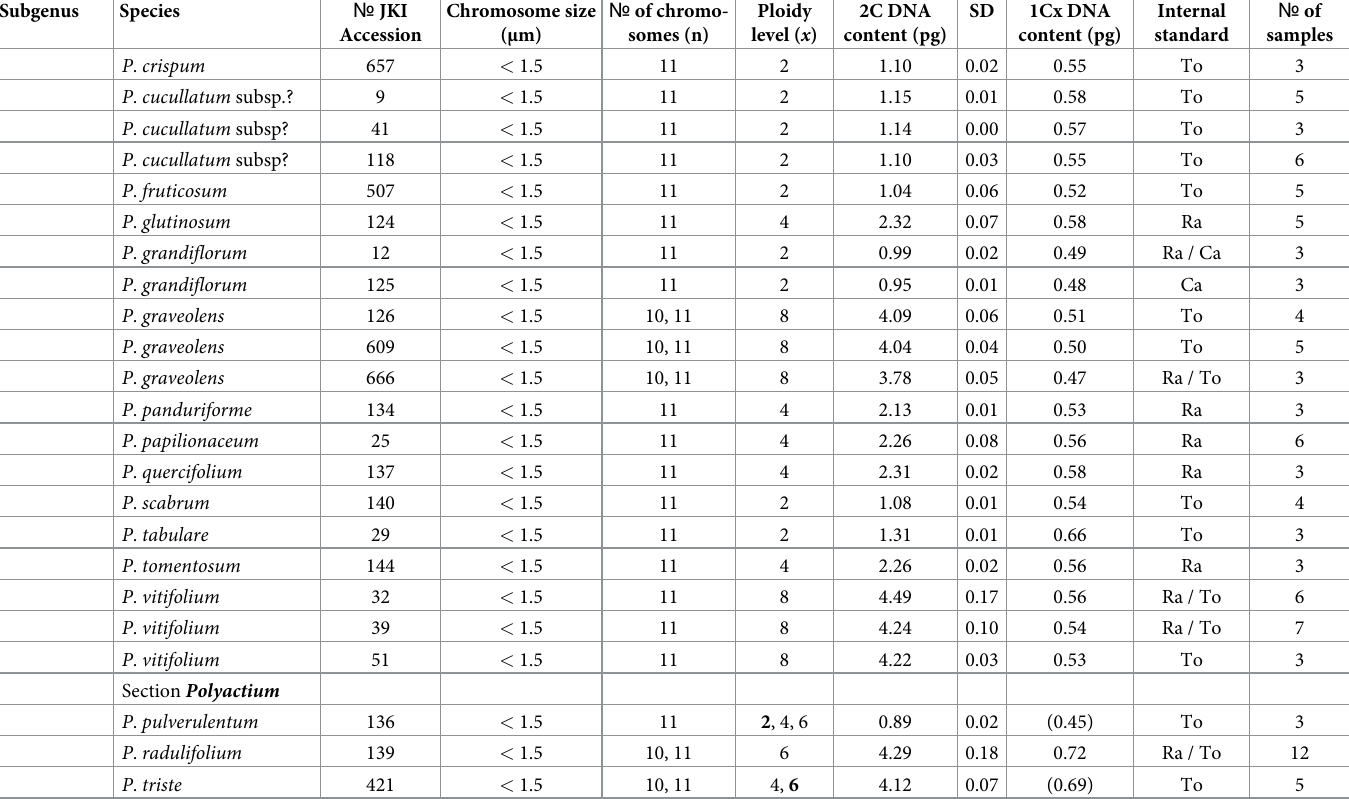
ence 2C mean peak position. The 1C x DNA content was determined by dividing the 2C DNA content by the known ploidy.